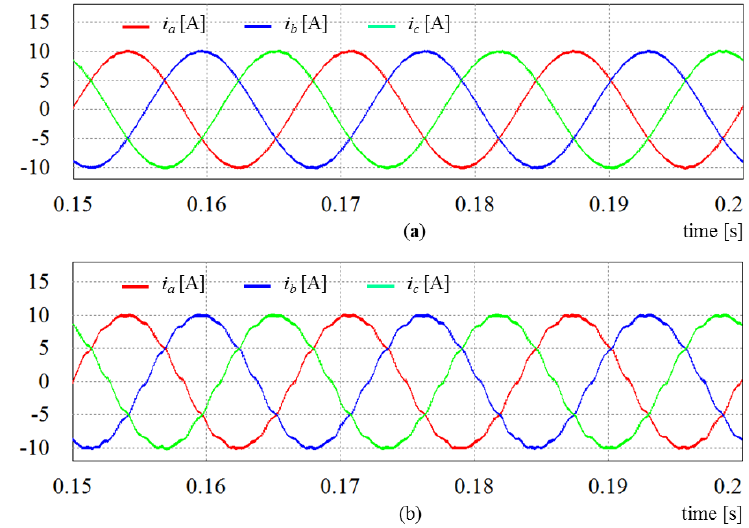
Figure 11. Inverter currents using PR controller with different distorted grid conditions: ( a ) The case when the grid disturbance only contains 5th and 7th harmonics. ( b ) The case when the grid disturbance contains 5th, 7th, 11th and 13th harmonics.